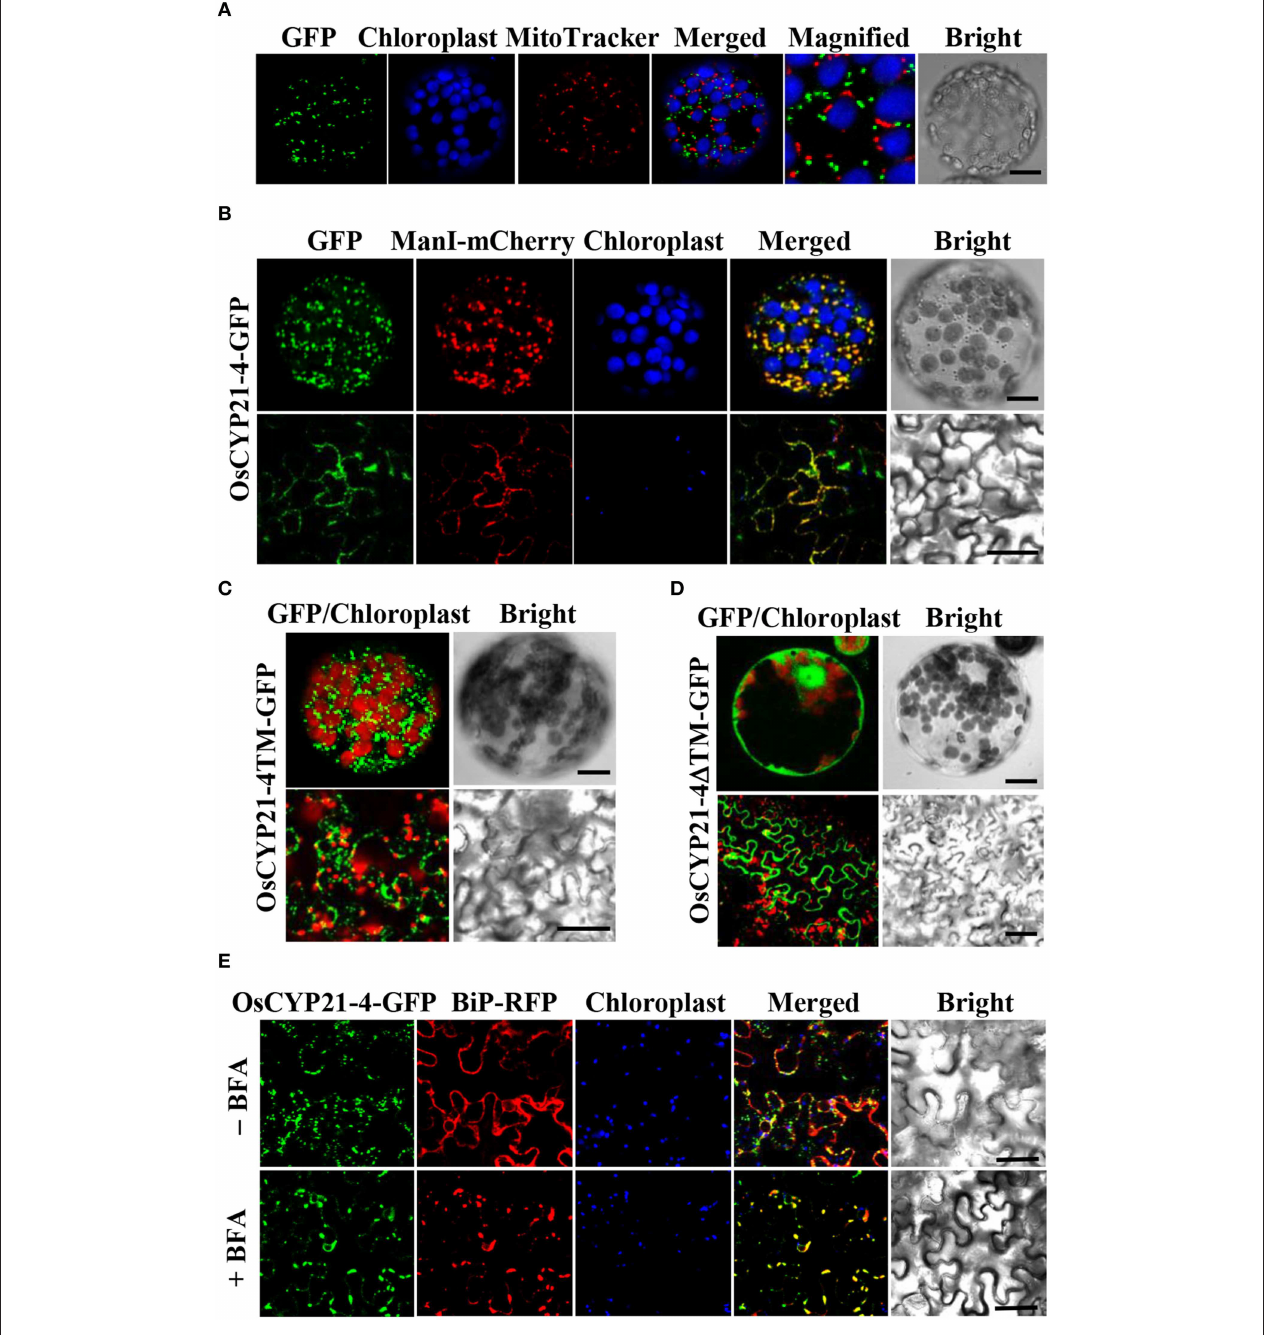
FIGURE 2 | Localization of OsCYP21-4-GFP in N. benthamiana . (A) OsCYP21-4-GFP did not co-localize with the mitochondrial marker, MitoTracker. (B) OsCYP21-4-GFP co-localized with the Golgi Apparatus marker α -ManI-mCherry. (C,D) Subcellular localizations of OsCYP21-4TM-GFP and OsCYP21-4 1 TM-GFP proteins. (E) Co-localization of OsCYP21-4-GFP with the ER marker, BiP-RFP under treatment with or without 50 µ M BFA for 3h. Bars = 20 µ m.